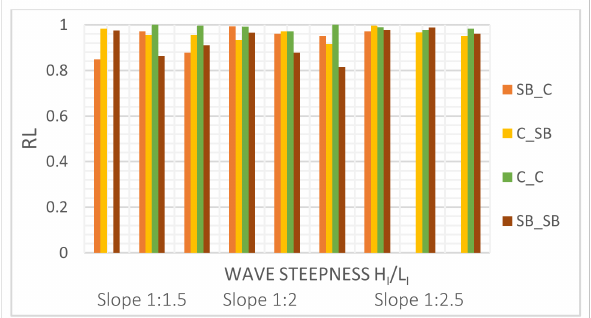
Figure 16. R L as compared to wave